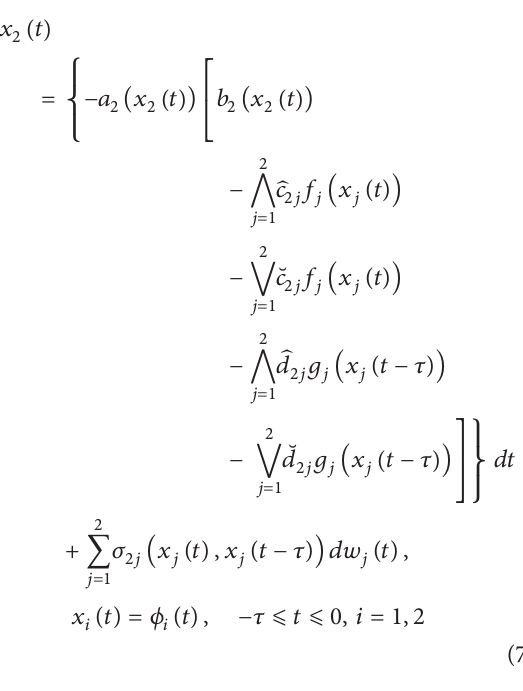
Figure 1: The state variable V 1 (𝑡,𝑥)